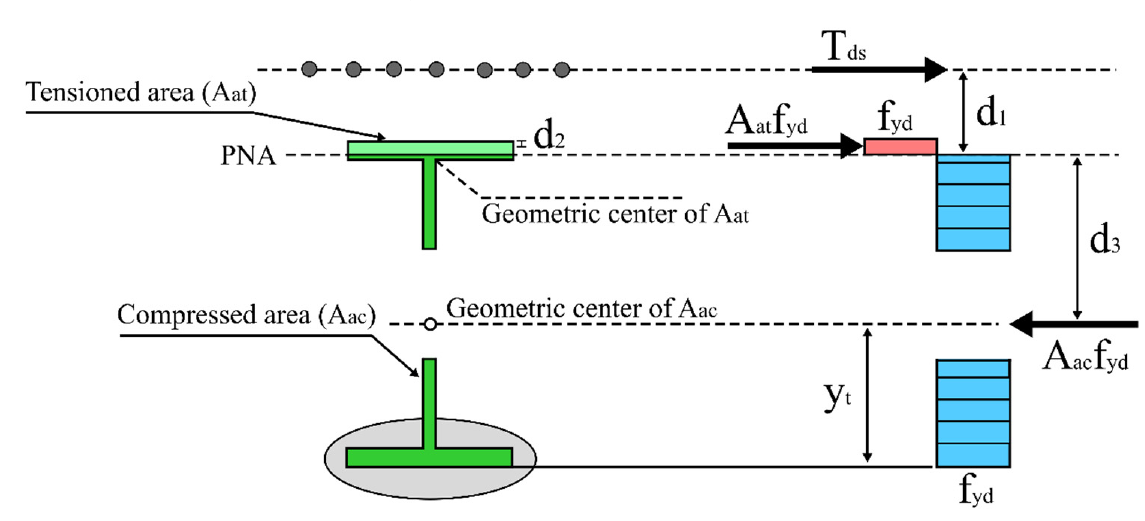
Figure 15. PNA on the I-section upper flange.